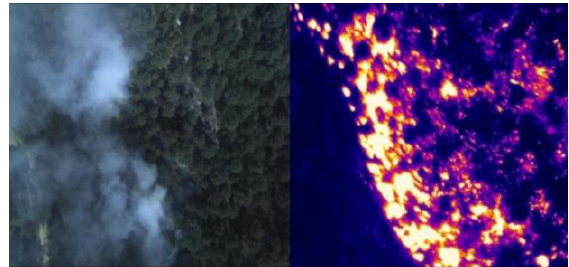
Figure 8 : Example of an RGD and Thermal Infrared Mission (DLR